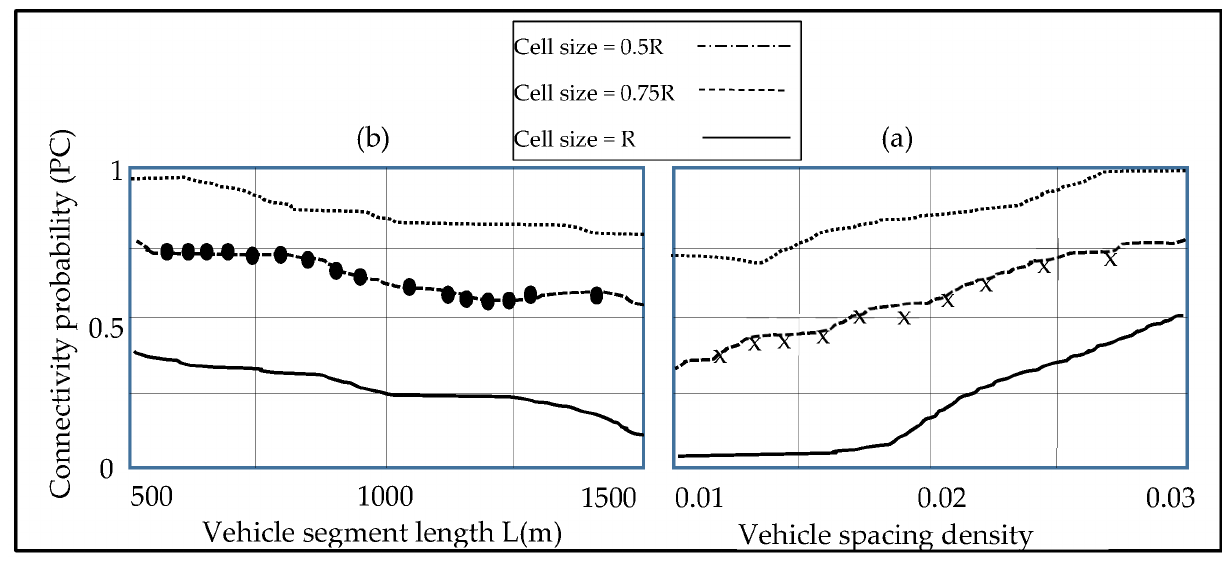
Figure 3. Road signal connectivity depends on the connectivity and density. ( a ) shows the upper and lower bounds of the road segment connectivity for cs = R and cs = 0.5 R. Accordingly, the average analytical results (CI = 95%) closely match the simulation results for cs = 0.75 R. We set L = 1500 m and cs = 0.75 R in ( b ).